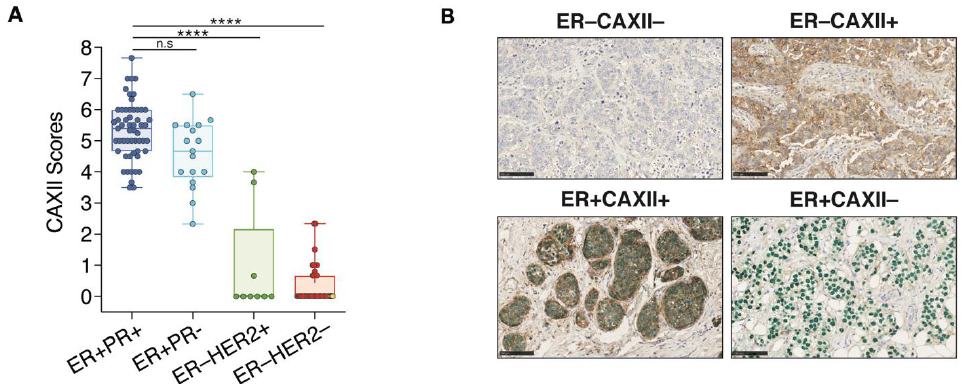
Figure 7. CAXII expression discriminates ER + from ER − breast tumors. ( A ) Boxplot representing CAXII score distribution according to ER, PR and HER2 status (7 arrays, n = 118; ns, p > 0.05; ****, p ≤